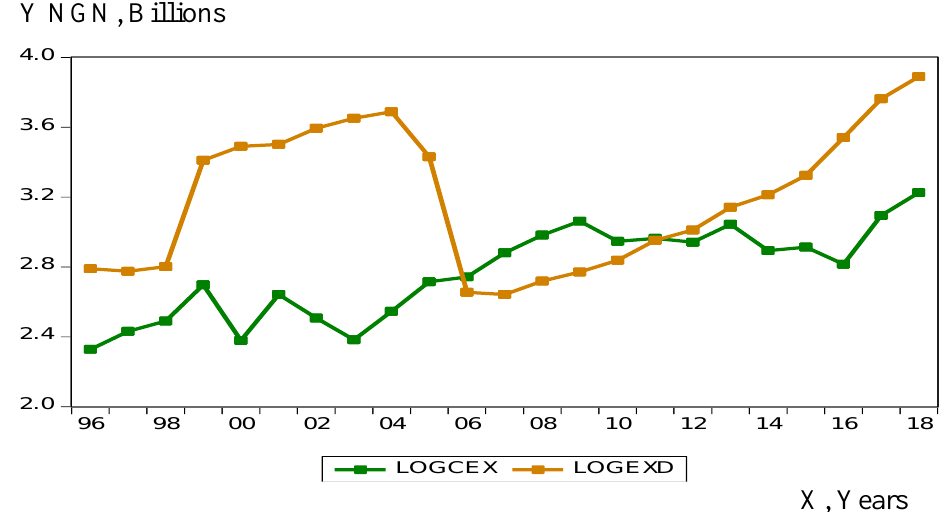
Fig. 2. Data trends from 1996 to 2018 (Central Bank of Nigeria Statistical Bulletin,